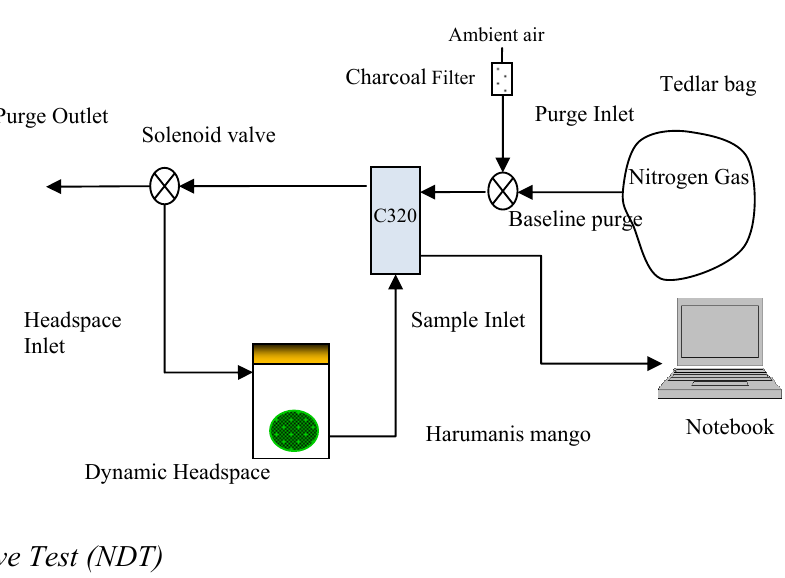
Figure 2. Block diagram of odour data collection